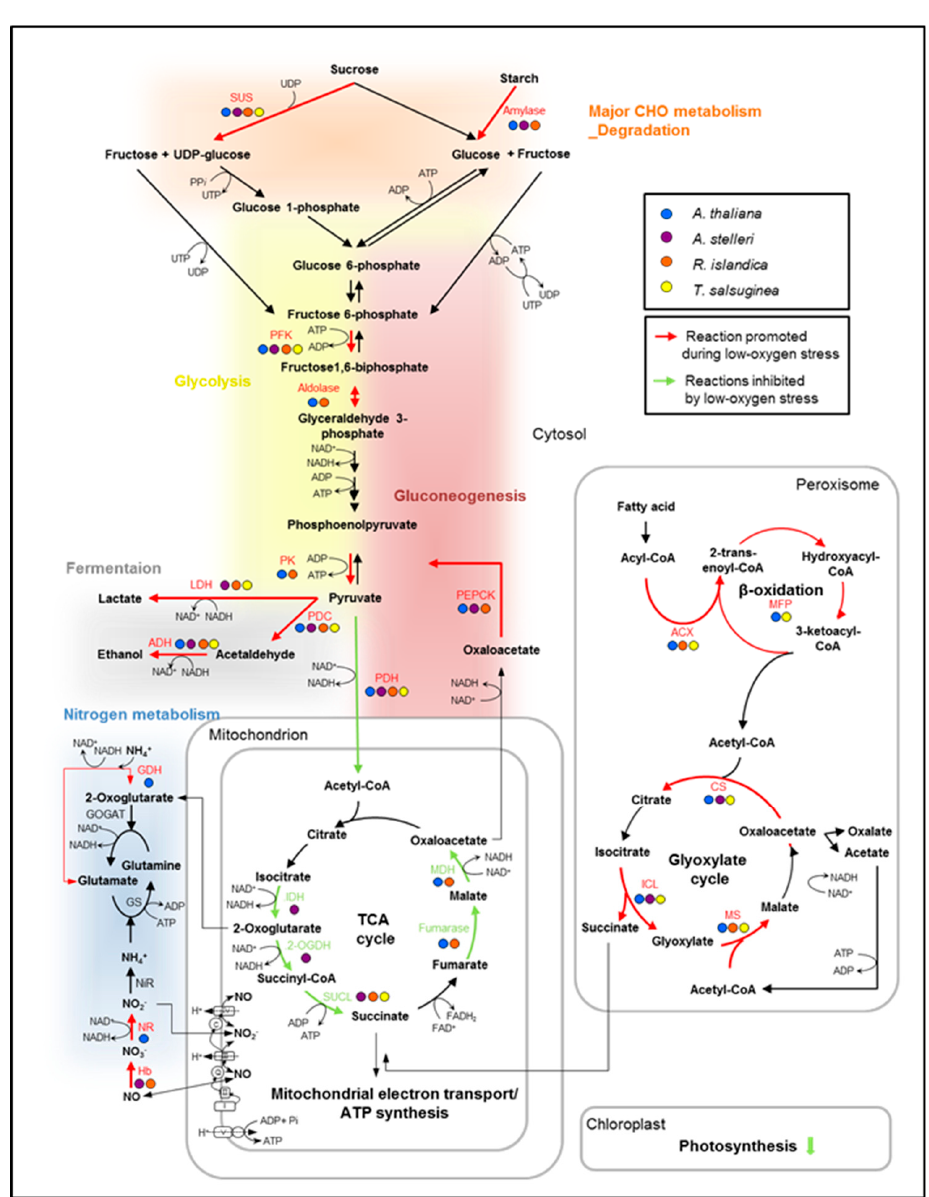
Figure 6 . Hypothetical alterations of the metabolic pathways for ATP production in low-oxygen stress response. In the diagram, the metabolic changes caused by oxygen deprivation were characterized by comparing changes in the expression of genes that are involved in the energy-metabolic pathways. The transcript expression of key genes was compared in the low-oxygen stress response of the four species. The genes upregulated or downregulated at least two-fold in each species were indicated in the pathway. Red arrows indicate reactions that are commonly promoted during low-oxygen stress, and green arrows indicate reactions inhibited by low-oxygen stress. Abbreviations are as follows: 2-OGDH, 2-oxoglutarate dehydrogenase; ACS, acetyl-CoA synthase; ACX, acyl-CoA oxidase; ADH, alcohol dehydrogenase; CS, citrate synthase; FK, fructokinase; GDH, glutamate dehydrogenase; GOGAT, glutamine oxoglutarate aminotransferase; GS, glutamine synthase; Hb, hemoglobin; ICL, isocitrate lyase; IDH, isocitrate dehydrogenase; LDH, lactate dehydrogenase; MDH, malate dehydrogenase; MFP, multifunctional protein (in β -oxidation); MS, malate synthase; NiR, nitrite reductase; NR, nitrate reductase; PDC, pyruvate decarboxylase; PDH, pyruvate dehydrogenase; PEPCK, phosphoenolpyruvate carboxykinase; PFK, phosphofructokinase; PK, pyruvate kinase; SUCL, succinyl-CoA ligase; SUS, sucrose synthase.